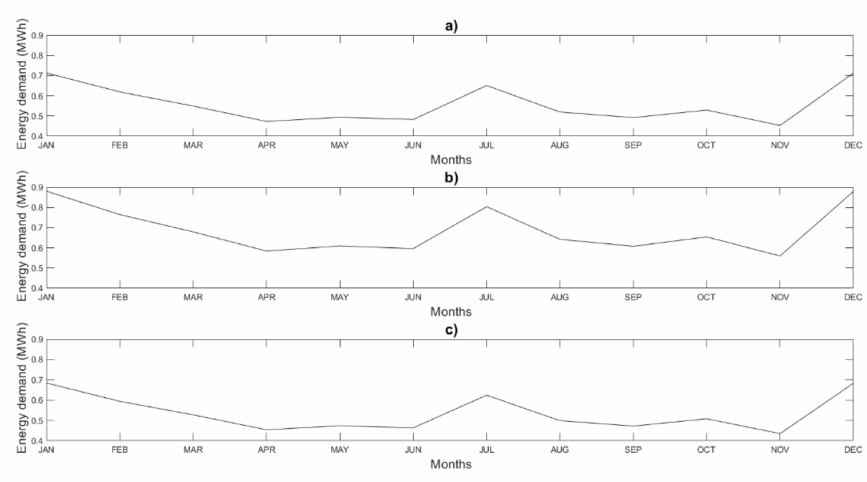
Figure 2. Energy demand during the year for each system: ( a ) Current AC system. ( b ) AC system with battery. ( c ) Combined AC / DC system with